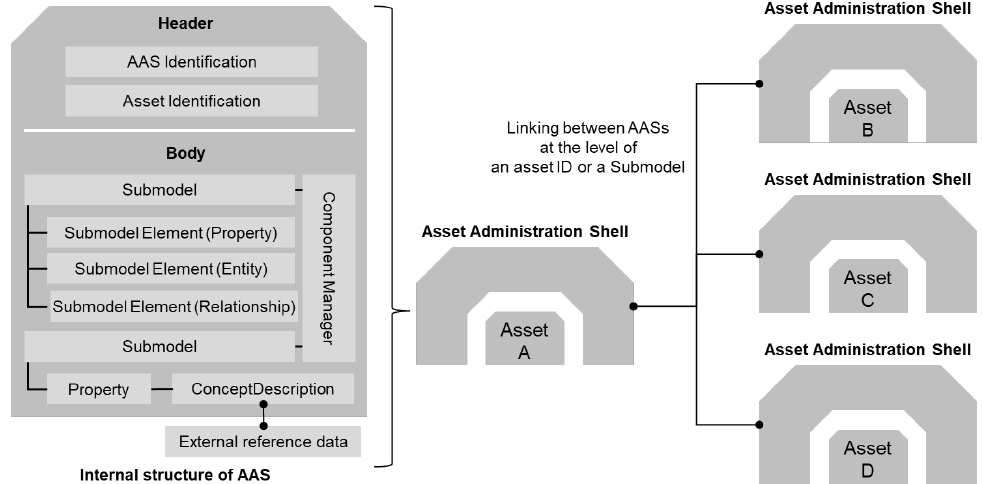
Figure 5. Model definition using the AAS meta-data model.